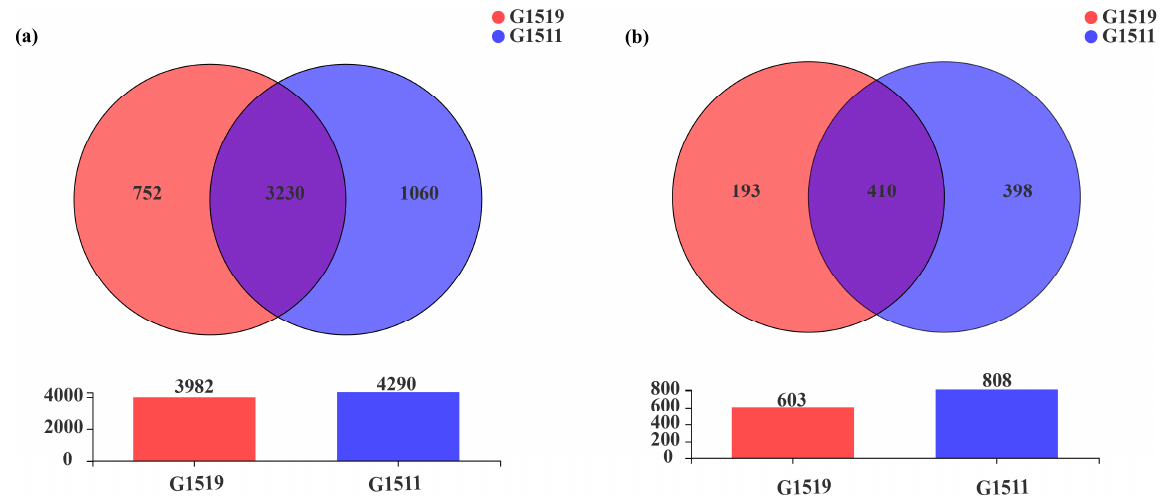
Figure 2. Venn diagram of the soil bacteria ( a ) and fungi ( b ) in the rhizospheres of the two pumpkin cultivars (G1519 and G1511) at the OTU level.